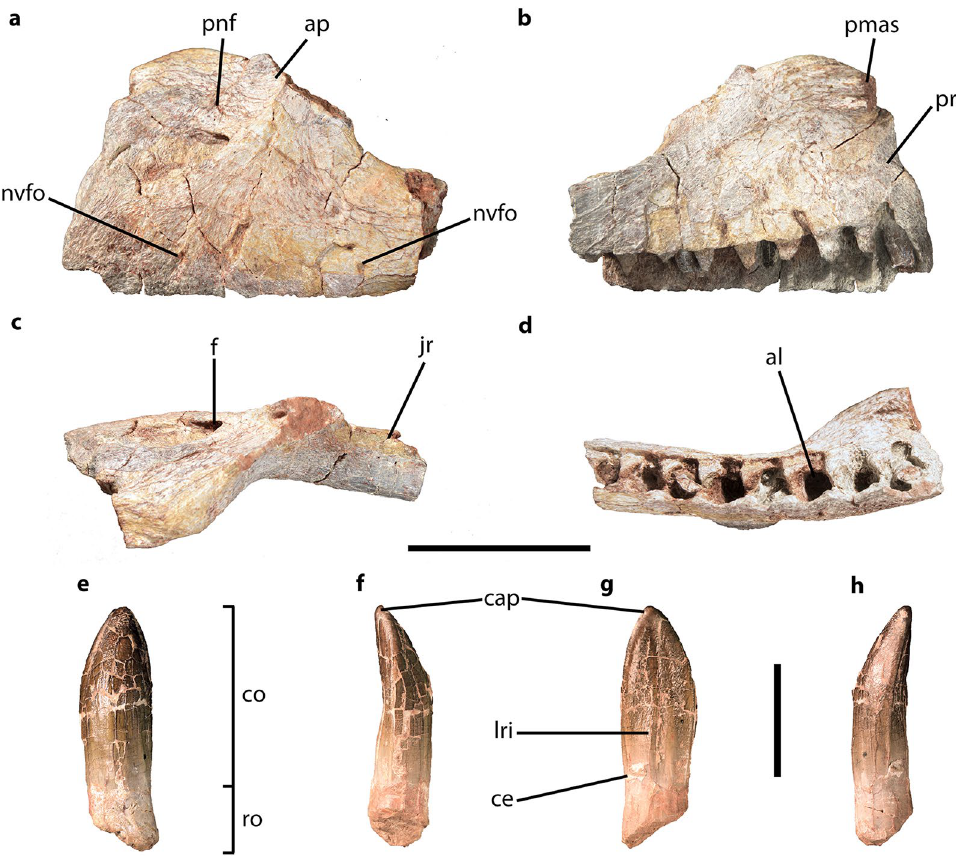
view. Abbreviations: al, alveoli; ap, ascending process; cap, crown apex; ce, cervix; co, crown; f, foramen; jr, jugal ramus; lri, longitudinal ridge; nvfo, neurovascular foramen; pmas, premaxillary articular surface; pnf, perinarial fossa; pr, premaxillary ramus; ro, root. Scale bars = 5 cm ( a–d ); 1 cm ( e–h